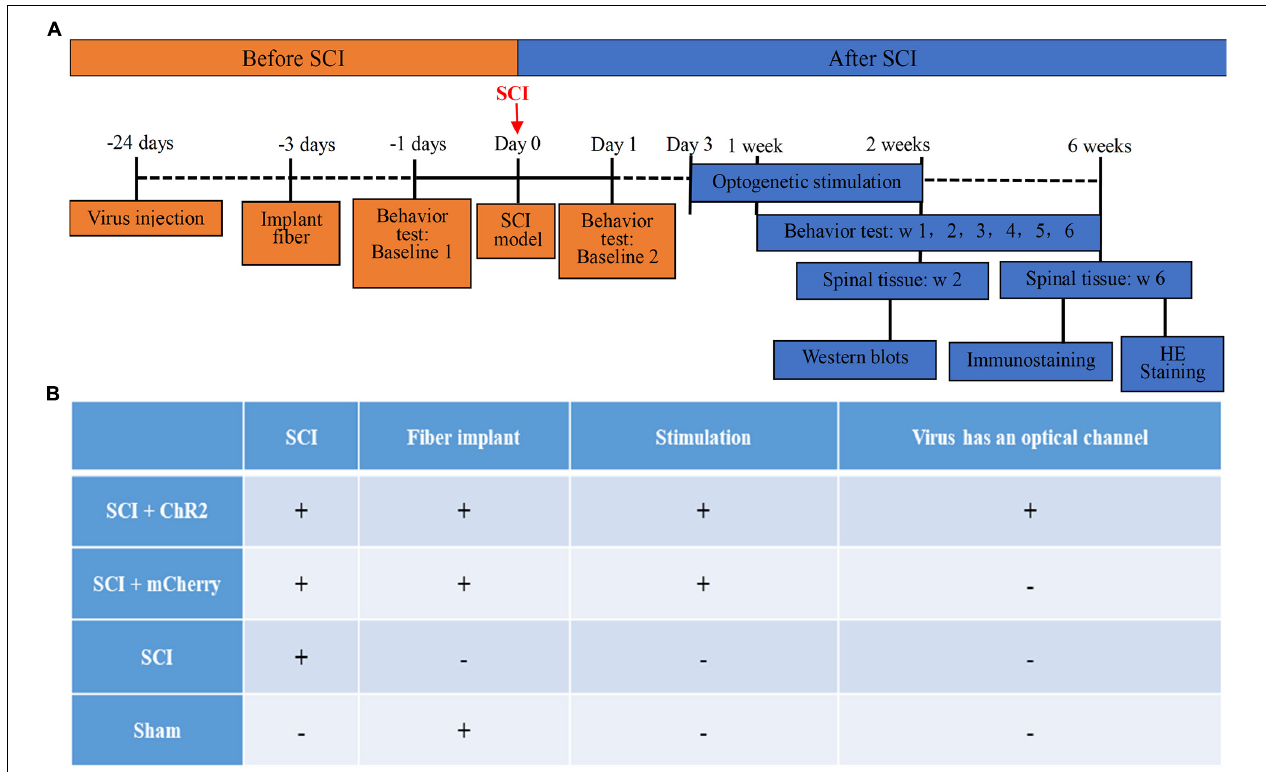
FIGURE 1 | The timeline and grouping diagram of this study. (A) The overall timeline of the experiment. virus injection and installation of optical fiber porcelain head need to be completed about 3 weeks before SCI modeling. Light stimulation is carried out from 3 days to 2 weeks after successful modeling. Spinal cord tissue samples are taken after stimulation, which are used for WB detection of protein. The weekly behavioral score starts from the first week after modeling and ends at the sixth week. At the 6th week, spinal cord tissue was collected for immunofluorescence staining and HE staining of nerve fibers at spinal cord injury. (B) The grouping of this study and the corresponding treatment methods of each group. Animals were divided into four groups: SCI + ChR2 group (Spinal cord injury + Injected with ChR2 + Implanted with the cannula delivering blue light into M1 area), SCI + mCherry group (Spinal cord injury + Injected with mCherry + Implanted with the cannula delivering blue light into M1 area), SCI group (Only spinal cord injury), and Sham group (Sham spinal cord injury + Implanted with the cannula delivering blue light into M1